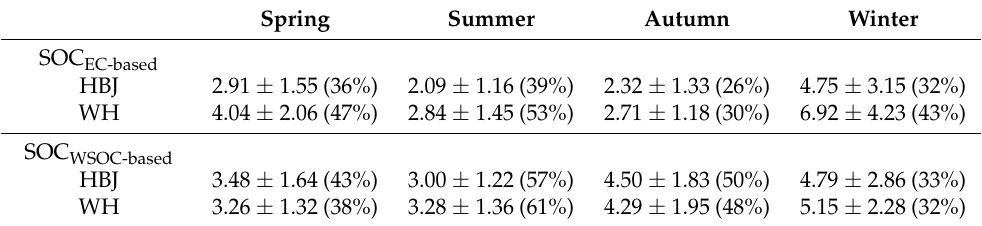
Table 3. Estimated SOC concentrations ( µ g · m − 3 ) and contributions to OC based on OC/EC and WSOC. Spring